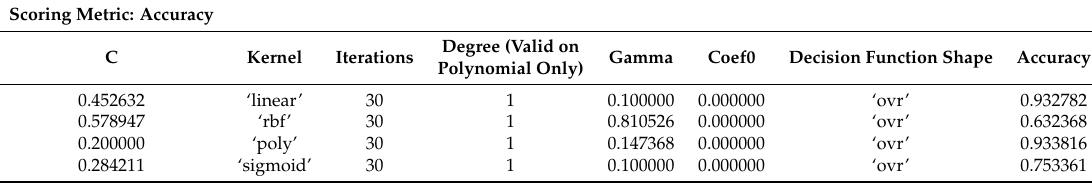
Figure 8. Multi-class problem—Grid Search SVM with sigmoidal Kernel, One vs. Rest decision function shape, 30 iterations, and a scoring criterion of accuracy, confusion Matrix ( a ) and ROC Curves ( b ). For each kernel, the best parameters and accuracy results are found by a grid search under the previously described conditions. The results obtained in this process are presented in Table 2. Table 2. SVM Parameters obtained using accuracy as the scoring metric (previously processed with multi-class